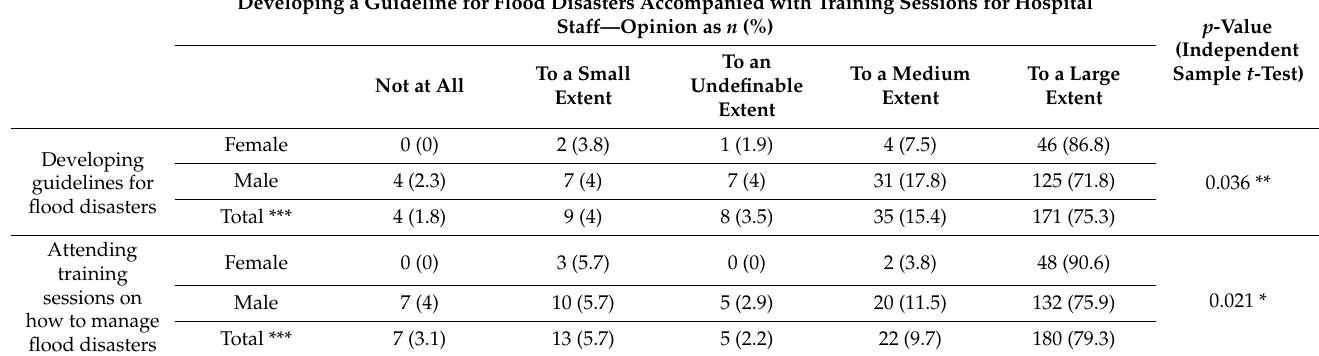
Table 4. Perception towards guidelines development and training sessions.